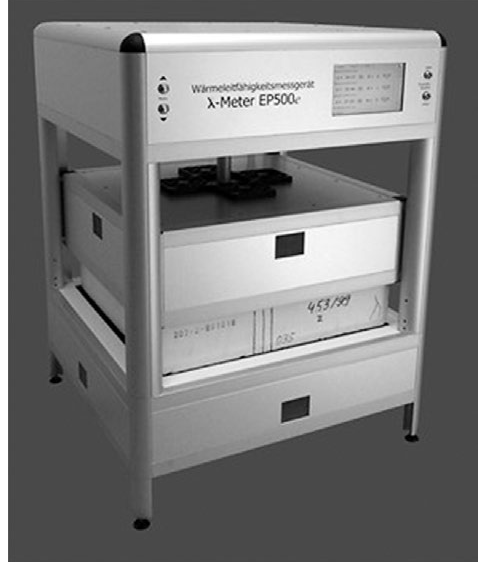
Fig. 2. Apparatus l -Meter EP-500 for testing thermal conductivity